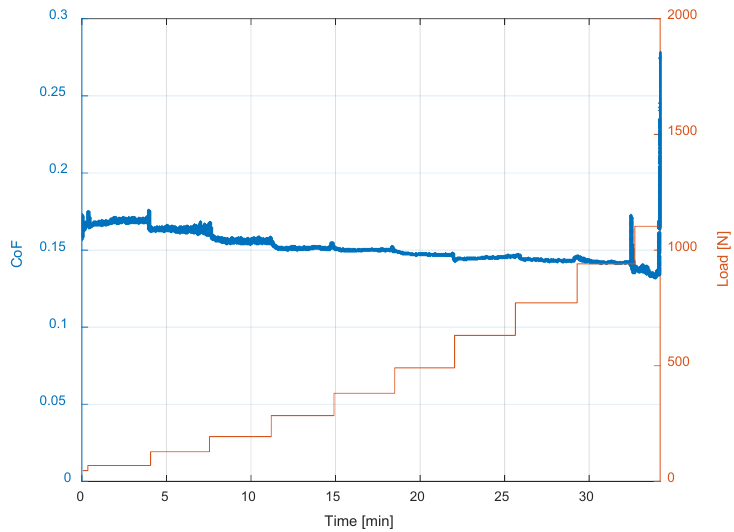
Figure 5. Case 1: example.